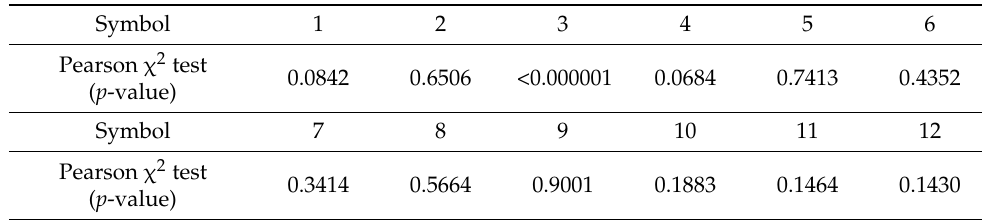
Table 2. Pearson’s test for time spent